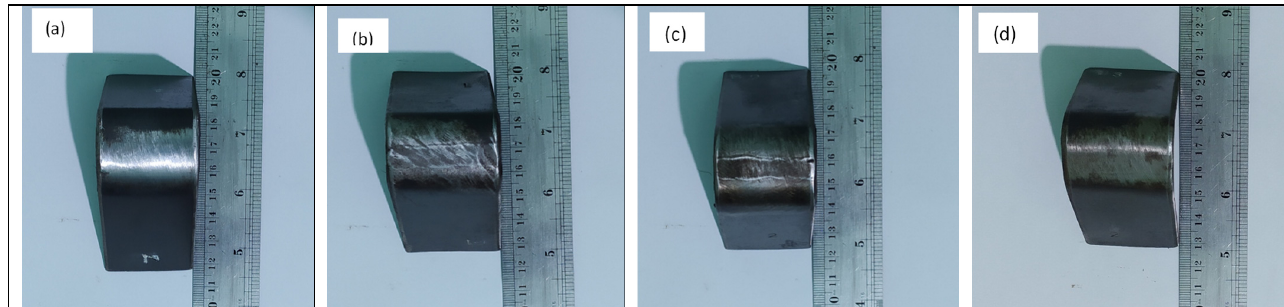
Figure 11. Results of the bending test on specimens welded under the following conditions: ( a ) air, ( b ) flowless underwater, ( c ) non-uniform flow with a bulkhead, ( d ) non-uniform flow without a bulkhead.